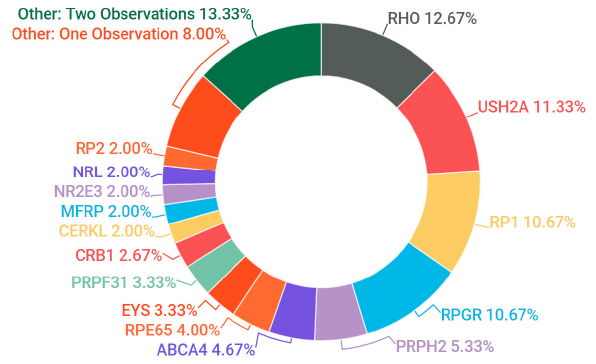
Figure 5. Gene candidates (and percentages) observed in cases of RP. Genes with two observations: CRX, IFT140, KLHL7, PDE6A, PDE6B, PROM1, PRPF8, ROM1, SLC24A1, SNRNP200 . Genes with single observations: AHI1, C2orf71, CNGA1, CNGB1, GNAT1, GUCA1B, HK1, IMPDH1, OFD1, PRPF6, RDH12, TULP1.